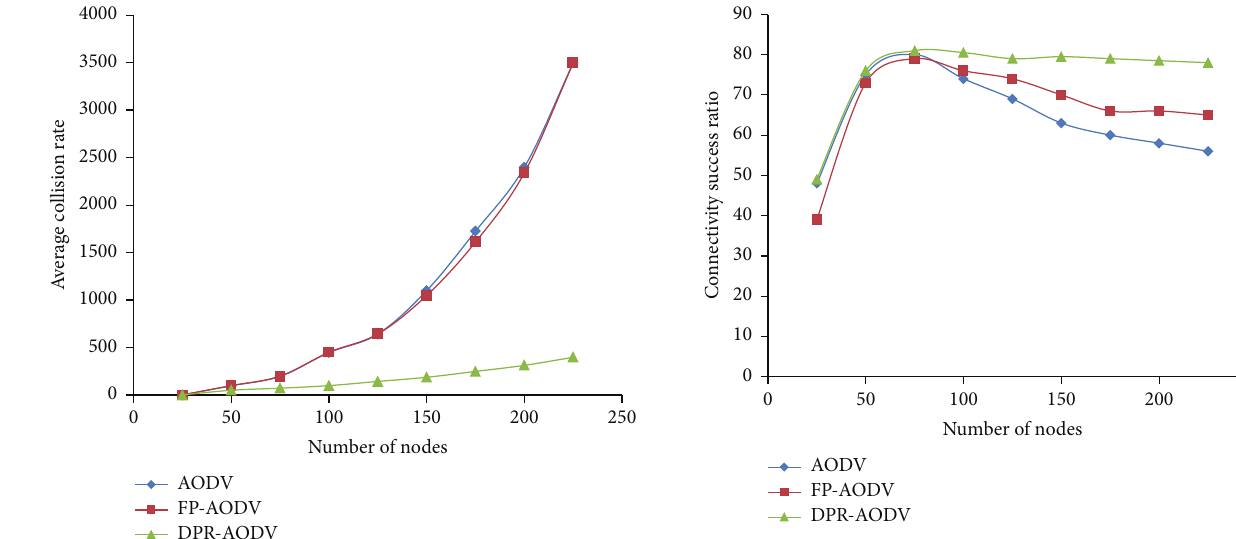
Figure 4: Average collision rate versus number of mobile nodes.